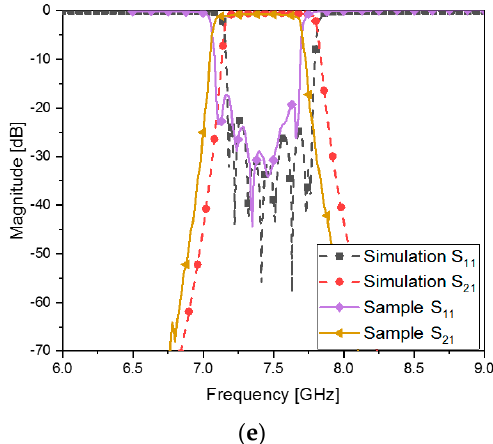
Figure 8. Prototyped eighth − order WG ZOR BPF via the CNC milling process. ( a ) Bird’s eye − view of the thin resonator with the round corners embedded in the flange body. ( b ) Front − view of the manufactured filter. ( c ) Top − view of the manufactured filter. ( d ) The device under test having the adaptors matched with the flanges. ( e ) S 11 and S 21 .